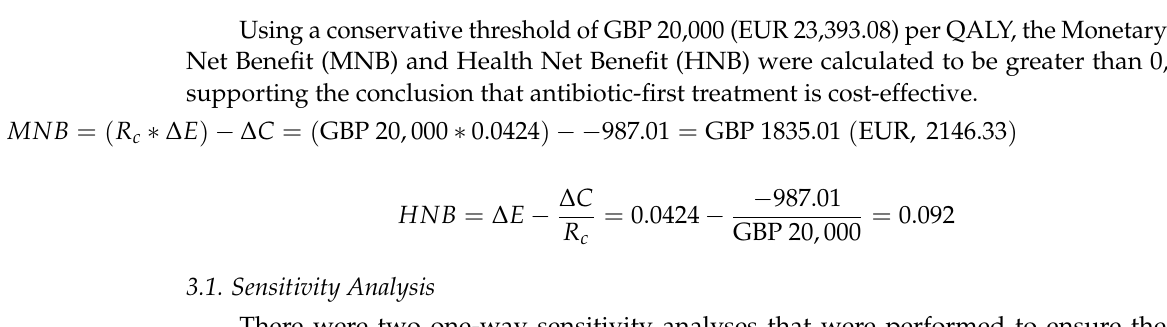
Figure 3. Cost-effectiveness plane diagram; ICER 0 = original; ICER 1 = sensitivity analysis 1; ICER ICER 2 = sensitivity analysis 2 = sensitivity analysis 2.